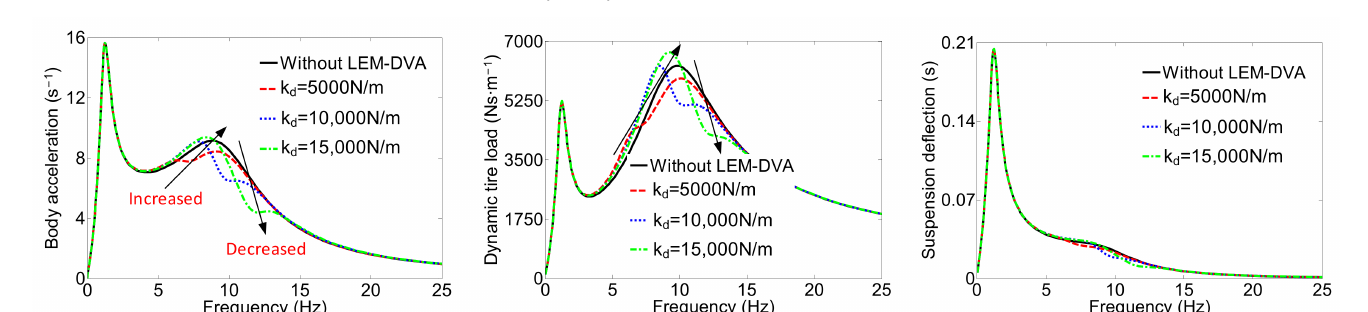
Figure 8. Sensitivity analysis on c d .